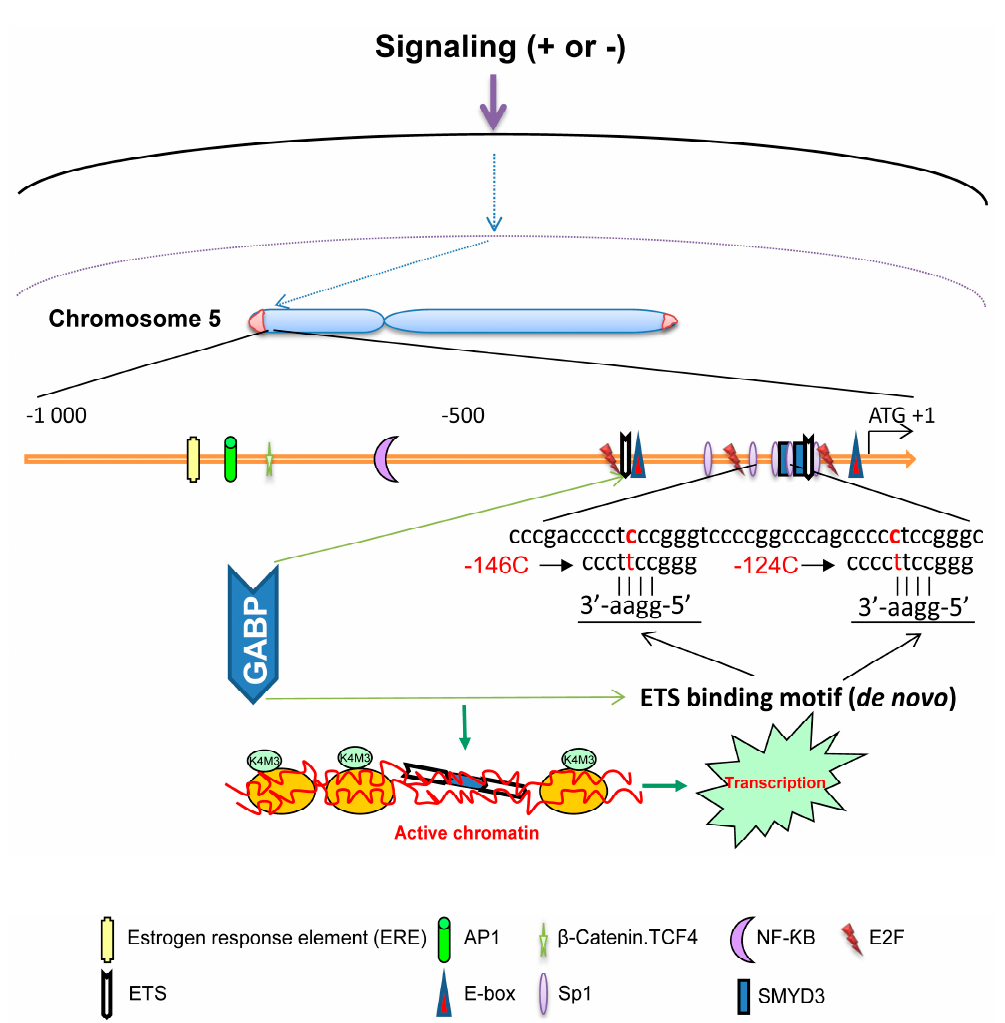
Figure 1. Schematic illustration showing the TERT promoter with its important transcription factor binding sites and cancer ‐ specific TERT promoter mutations. The TERT gene is at chromosome 5p and its promoter (from ATG to − 1000) with binding motifs for important transcription factors is shown. Both positive and negative regulators for TERT transcription signal to the TERT promoter where transcription factor binding occurs and the local chromatin becomes open or close. In malignant cells, C>T mutation may take place at one of both positions of the TERT proximal promoter ( − 124 and − 146 to ATG for − 124C>T and − 146C>T, respectively). These mutations create de novo ETS1 binding motifs. The ETS transcription family member GABP is recruited to the promoter and binds both native and de novo ETS motifs as a heterotetrameric complex, which leads to increased histone H3 ‐ K4 trimethylation and opened chromatin.